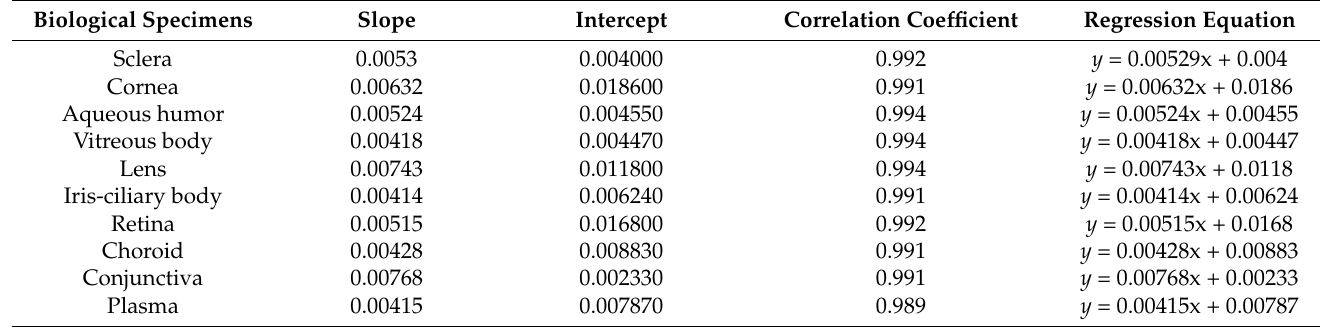
Table 1. Calibration curves for the determination of gatifloxacin concentration in different biologi- cal specimens.